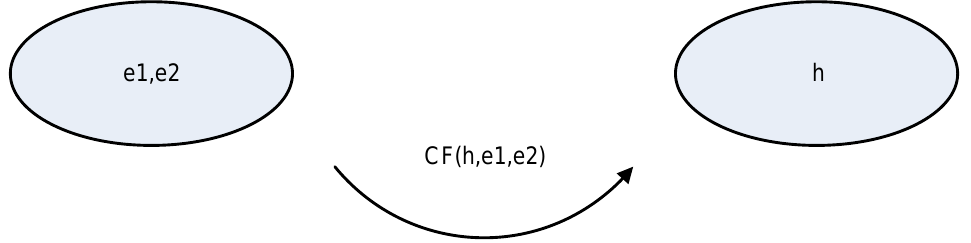
Figure 5. Result of simplification based on Formulas (4) or (5) (the authors’ own study based on [2]).